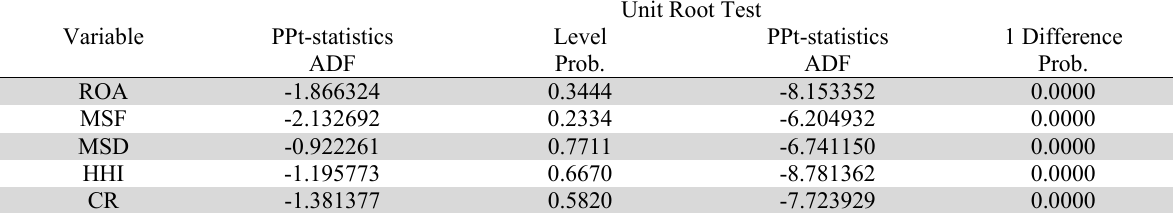
Philips – Peron Result for Unit Roots